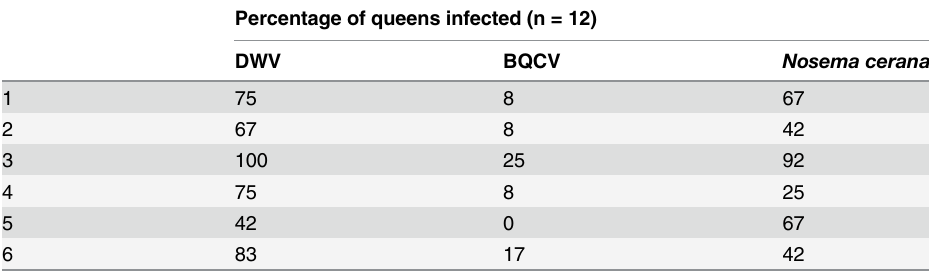
Table 1. Percentage of honey bee queens infected with Deformed Wing Virus (DWV), Black Queen Cell Virus (BQCV) and Nosema ceranae (n = 12 queens per breeder, July 2013) from six commercial queen breeders in the US as detected by